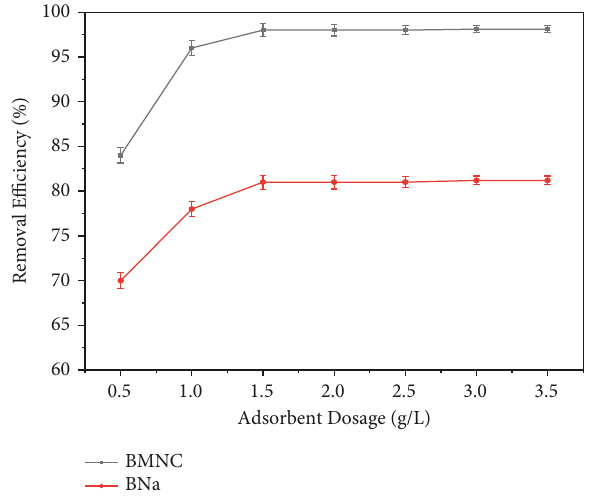
8: Effect of adsorbent dose on Cr(VI) removal efficiency by bentonite (BNa) and nanocomposite adsorbent (BMNC).